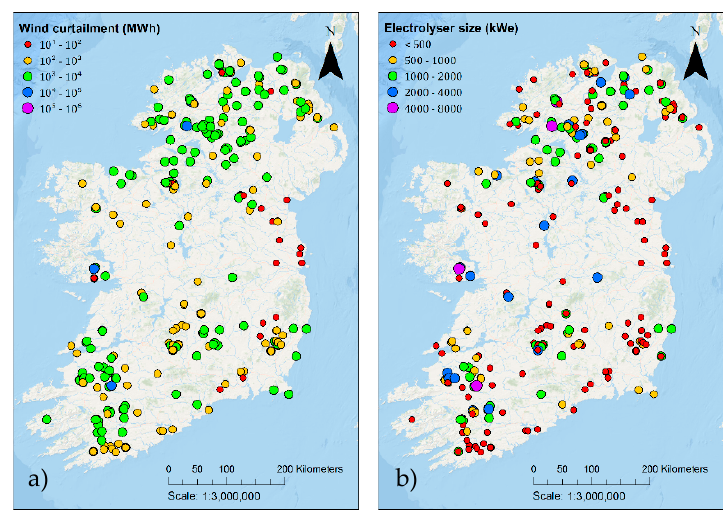
Figure 7. Wind farm distribution on the island of Ireland: (a) total energy of curtailed wind ( E CW ) and (b) optimum electrolyser size ( P WE,opt ) at each wind farm in Ireland.